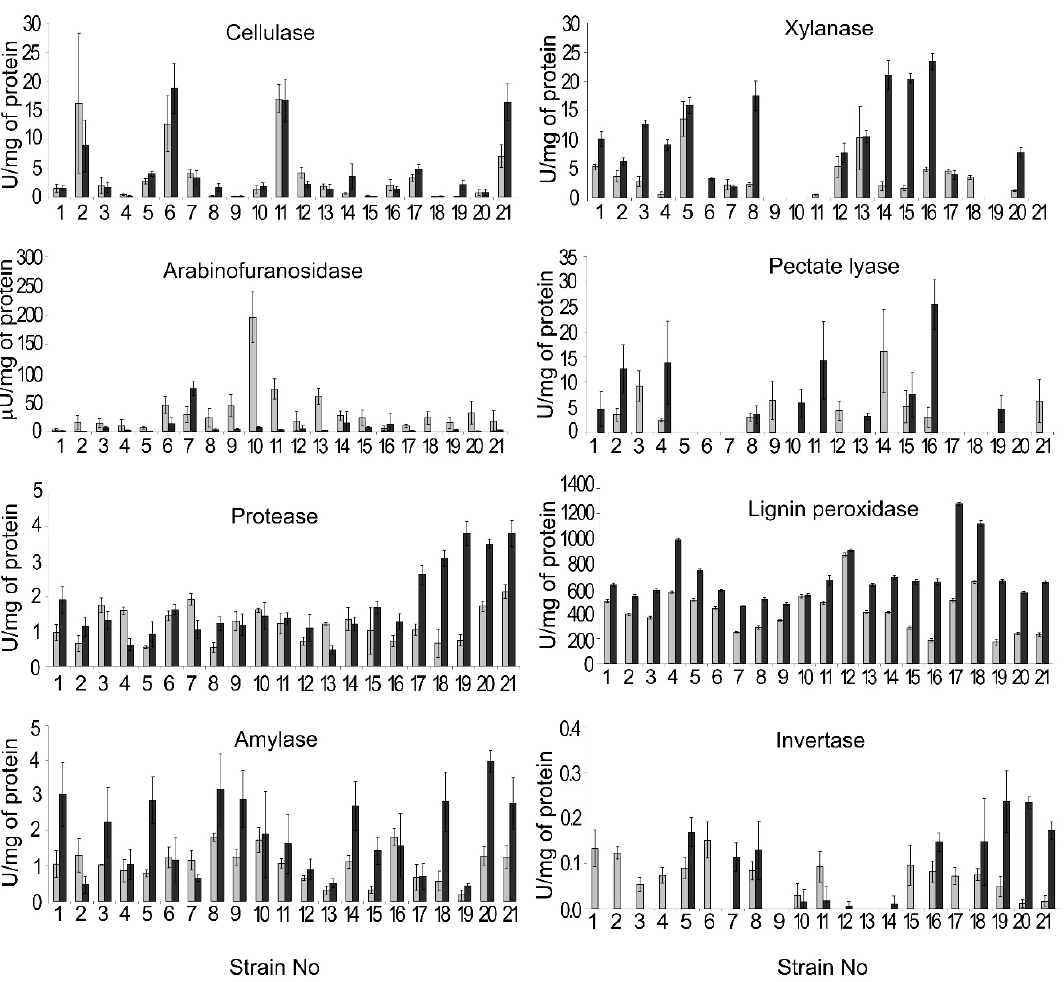
Figure 10. Extracellular enzymatic activities of the isolated Microdochium nivale strains. Light-gray column—20 days of cultivation; dark-gray column—30 days of cultivation. The presented values are averages ± SD of three biological replicates.